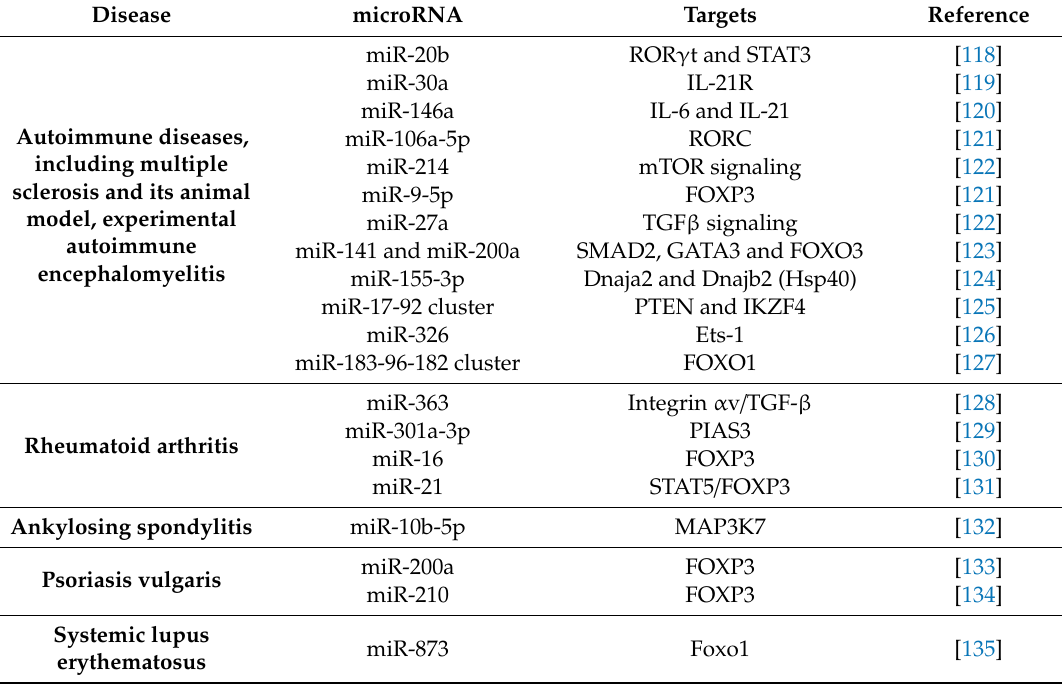
Table 1. MicroRNAs involved in the regulation of Th17 di ff